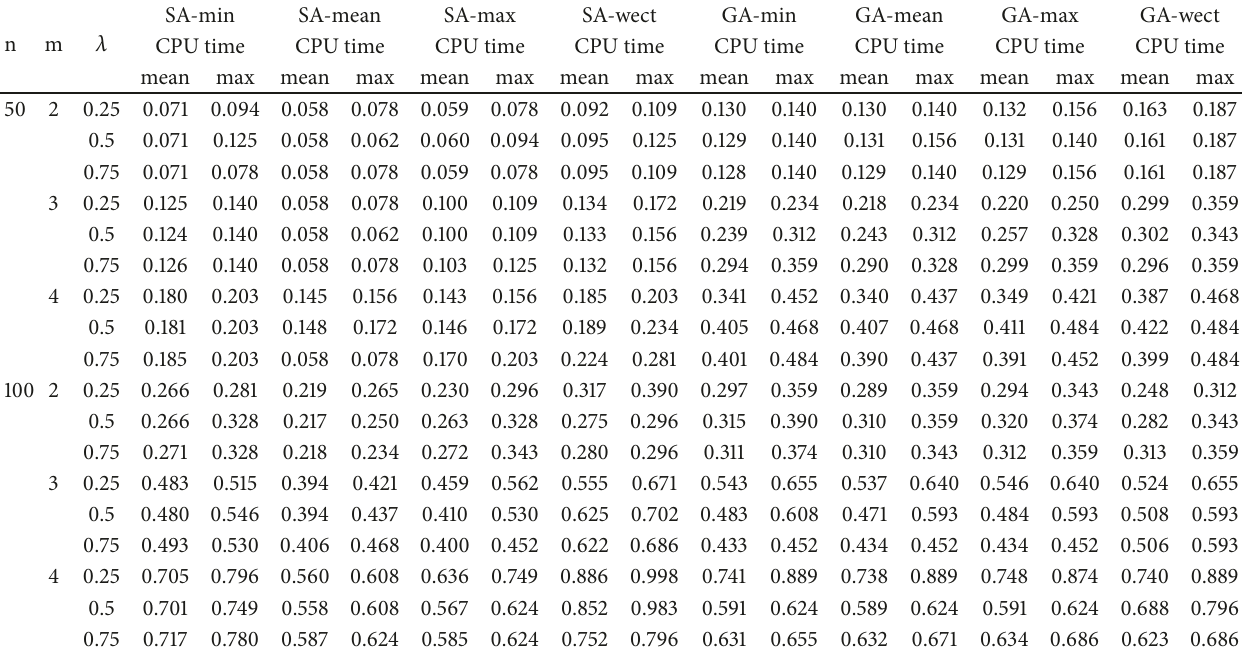
Table 11: CPU times (seconds) of the SAs and GAs for large number of